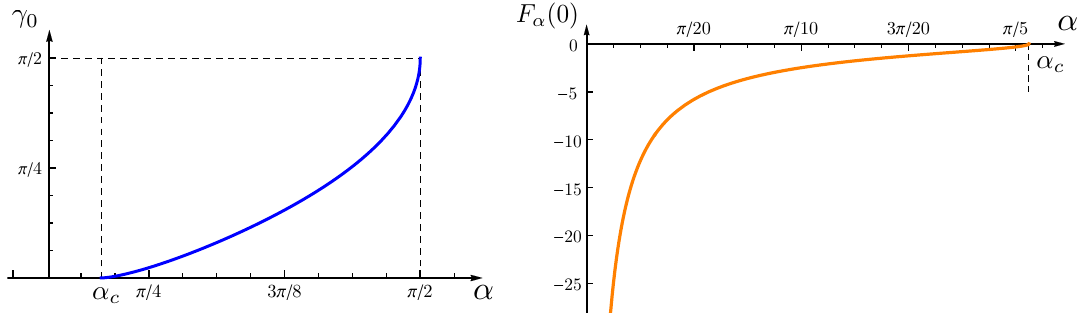
Figure 27 . Left: the function (cid:13) 0 ( (cid:11) ) for (cid:11) 2 [ (cid:11) c ; (cid:25)= 2], being (cid:13) 0 de(cid:12)ned by F (cid:11) ( (cid:13) 0 ) = 0. Right: the function F (cid:11) (0) in terms of (cid:11) 6 (cid:11) c